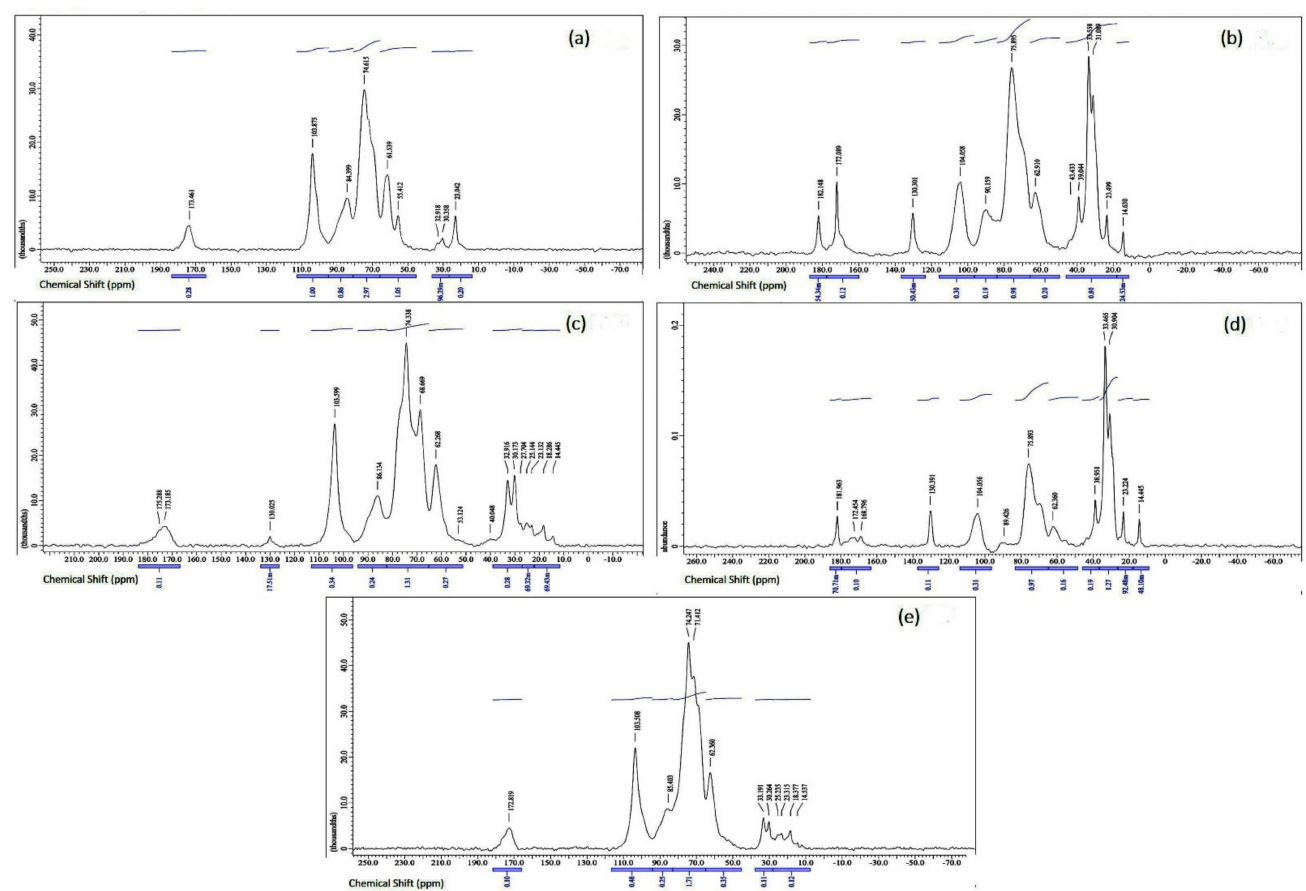
Figure 5. 13 C solid-state NMR spectra of commercially available BG ( a ), BG obtained from K. marxianus TISTR 5925 by alkaline ( b ) and enzymatic recovery ( c ), BG obtained from S. cerevisiae Kyokai NO. 9 by alkaline ( d ) and enzymatic ( e )